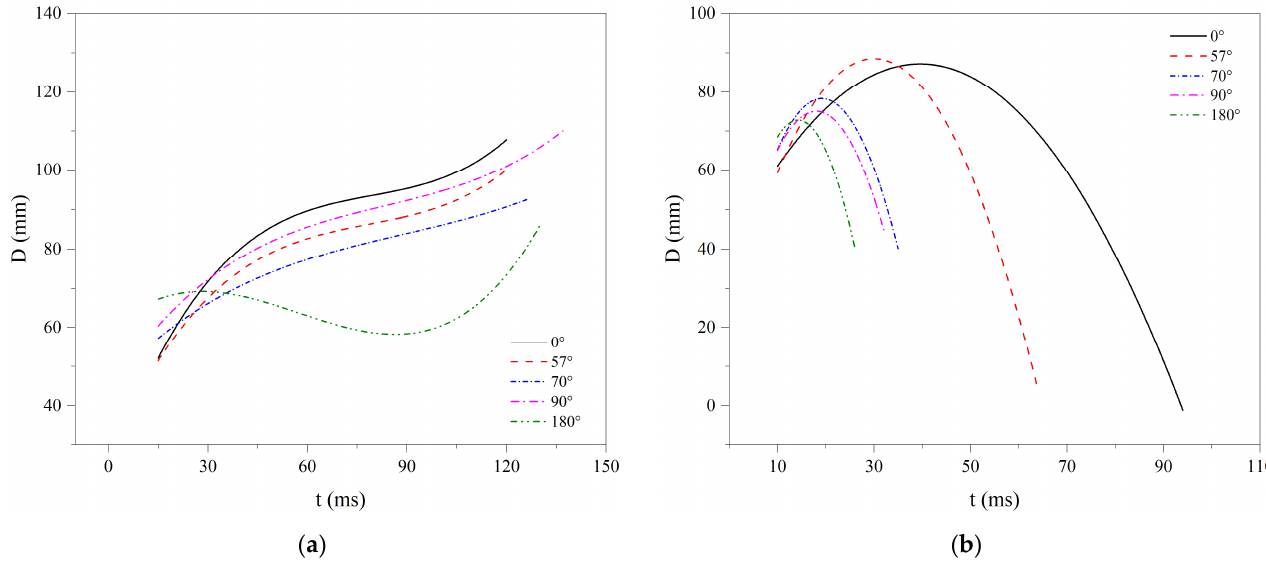
Figure 20. The splash diameter–time curve of the hydrophobic model. ( a ) The initial velocity v = 2.2 m/s. ( b ) The initial velocity v = 3.95